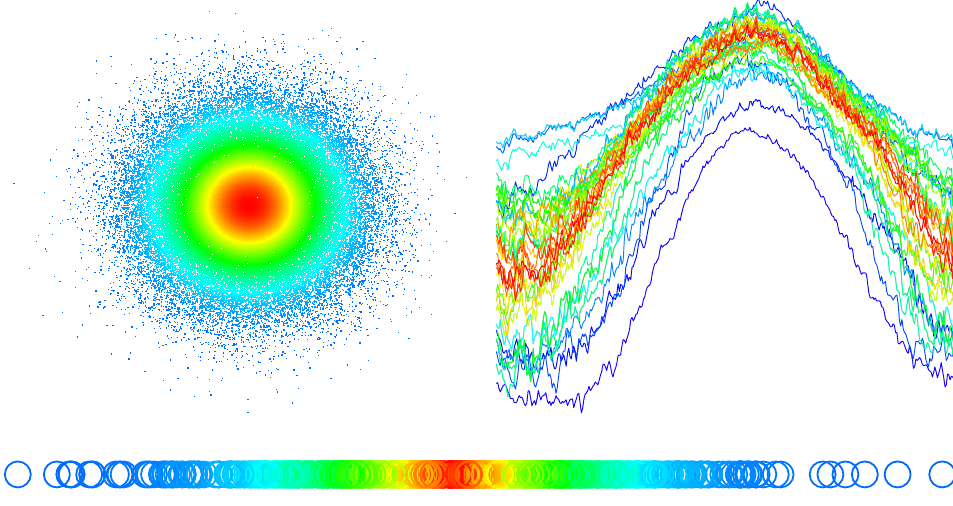
Figure 1. Top panels: 10 5 sample draws from a standard bivariate normal distribution ( left ) and a dataset of raw univariate functional data ( right ). Bottom panel: 10 3 sample draws from a standard normal distribution in dimension one. The color of the elements in each of the three plots represent the depth based on the distance to the center of symmetry of the